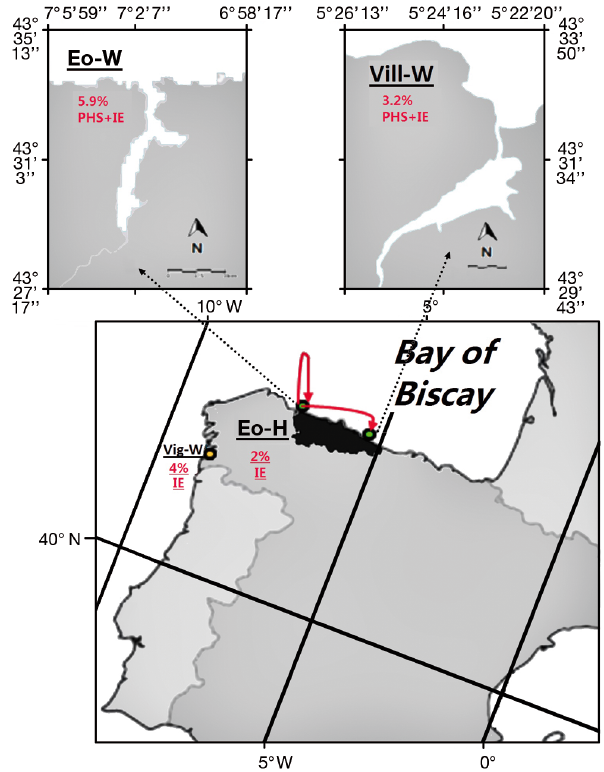
Fig. 1. Location of Asturias in the Bay of Biscay, with details of the 2 study sites: Ría del Eo (Eo) and Ría de Villaviciosa (Vill). Percentages of possible species misidentifications and introgression events (IE) detected in populations of sup- plemented Ruditapes decussatus from Asturias, northern Spain, after morphology and genetic assessments, are indi- cated together with previous findings in Ría de Vigo (Vig), Galicia, by Hurtado et al. (2011). Supplementation strategies and thus probable spreading of IE into wild populations are indicated by red arrows. RP: R. philippinarum ; W: wild; H: hatchery; PHS: possible hybrid